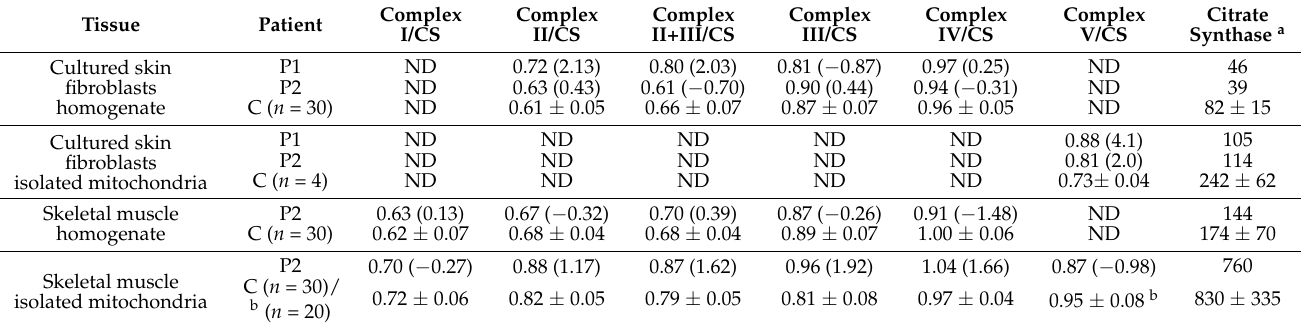
Table 1. OXPHOS complex activities as measured by spectrophotometry and normalized to citrate synthase